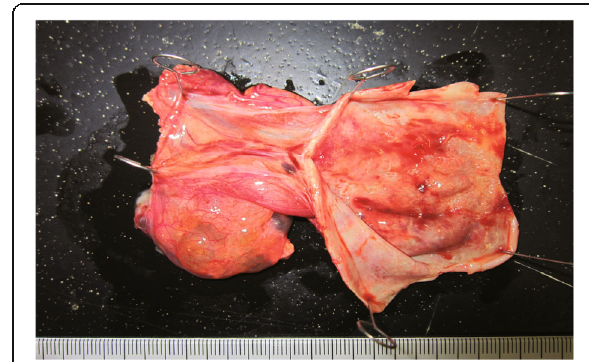
Fig. 3 Resection specimen. The diagnosis was cystic lymphangioma, and the histopathological findings showed the cystic tissue to be benign. The cytology (cyst fluid) was class